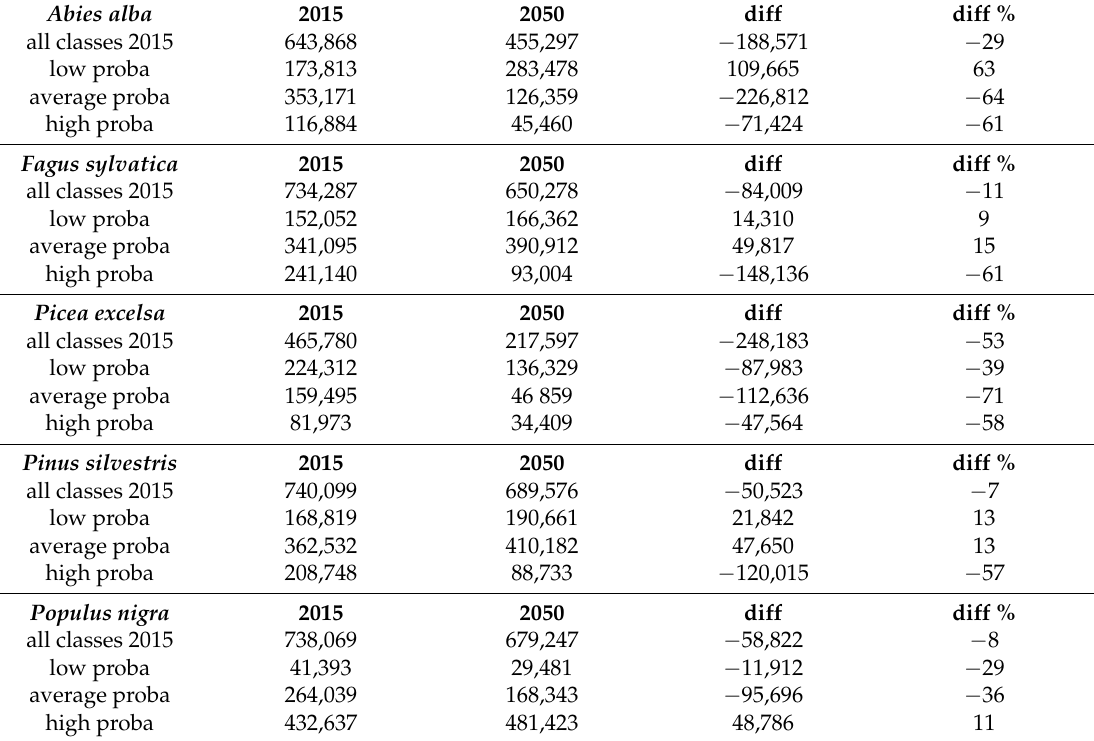
Table 2. Estimated amount of plots for suitable areas of the five tree species in 2015 and 2050 (diff = difference between 2050 and 2015; diff % is the percentage of this difference).